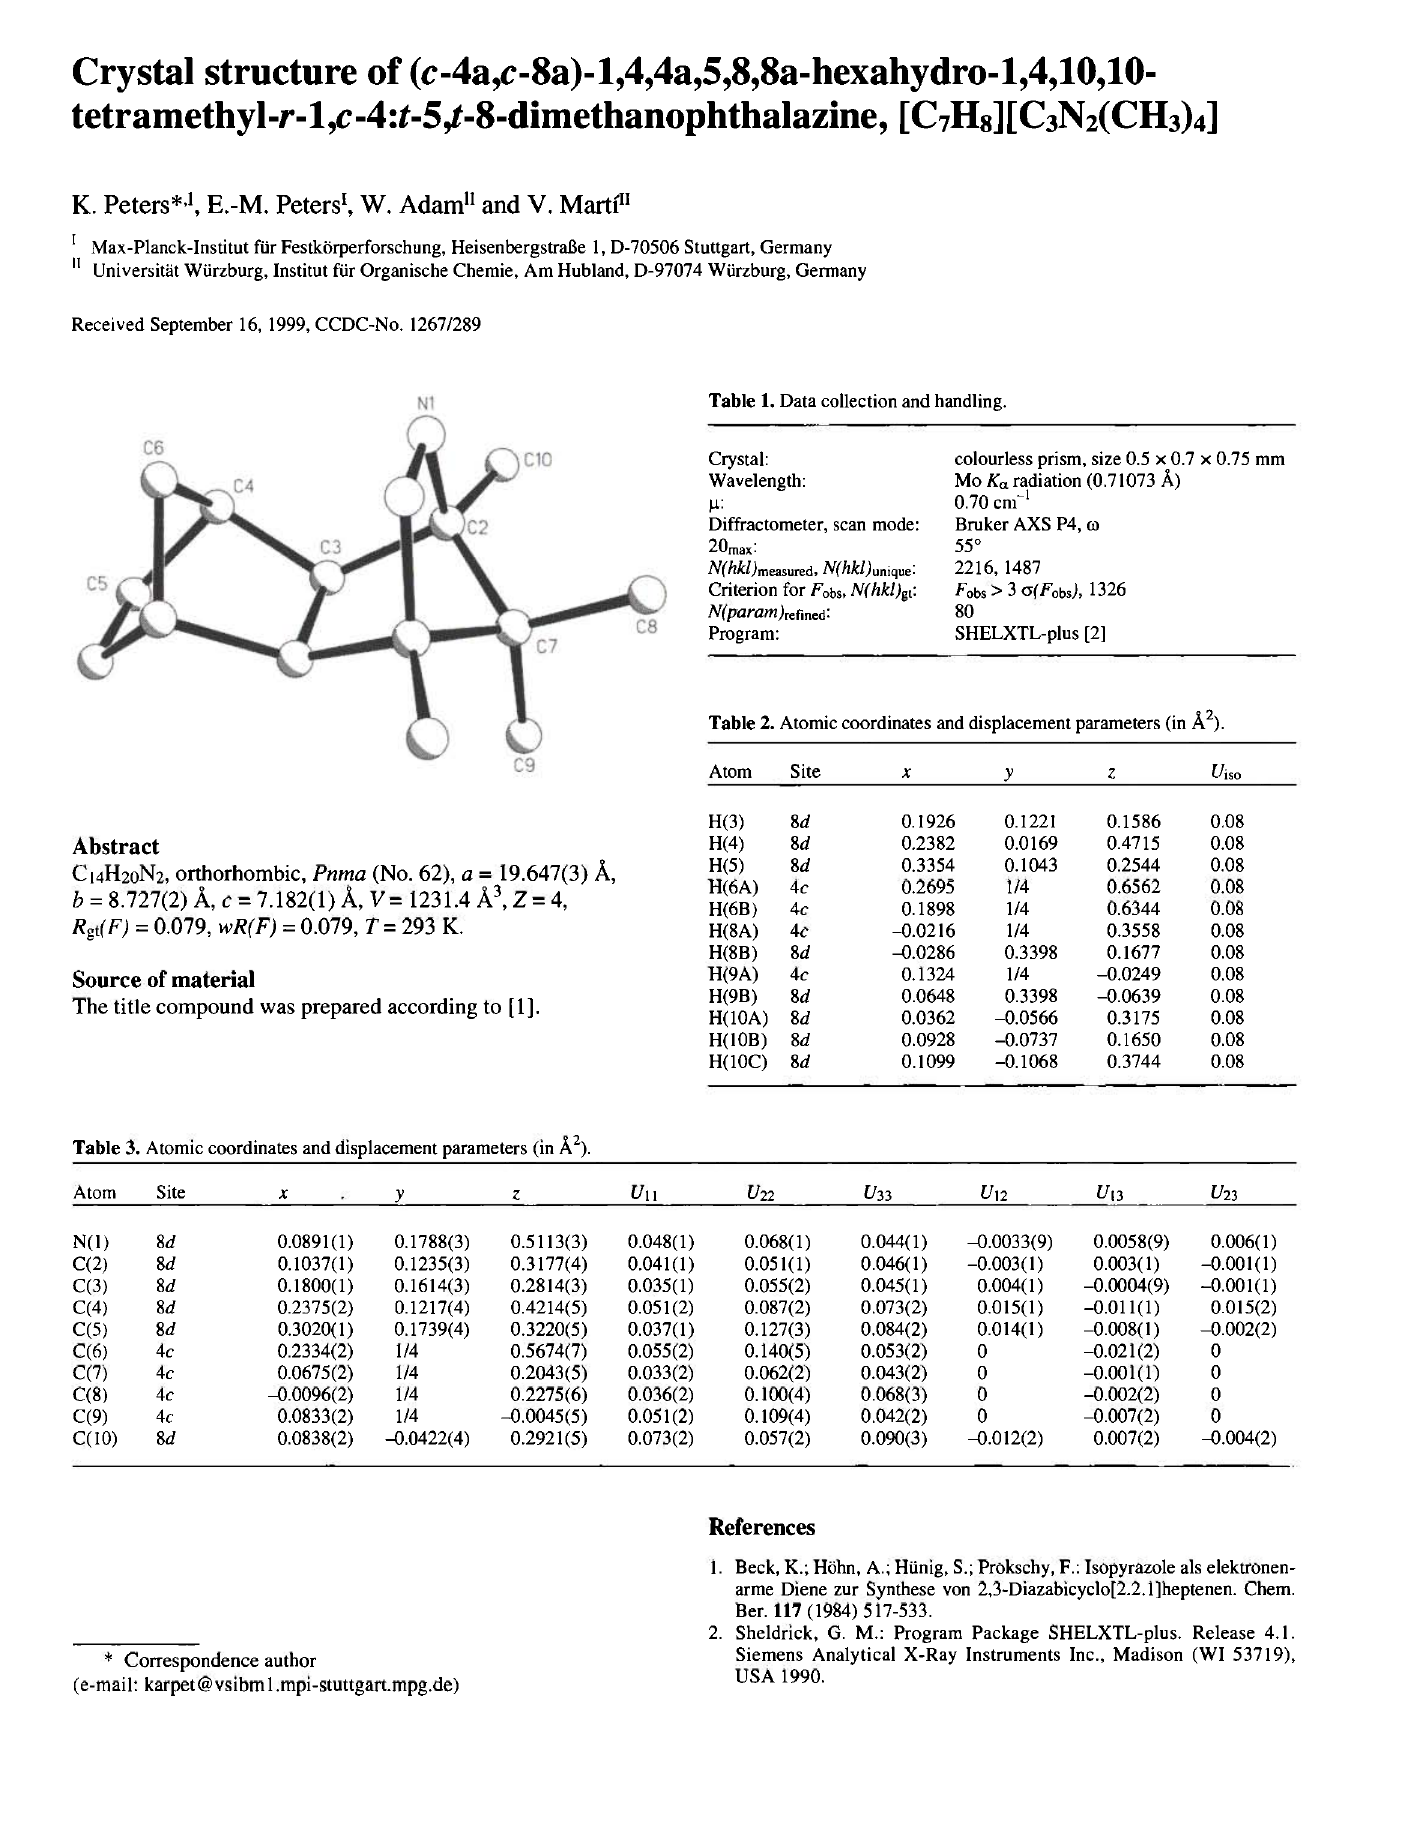
Table 1. Data collection and handling.